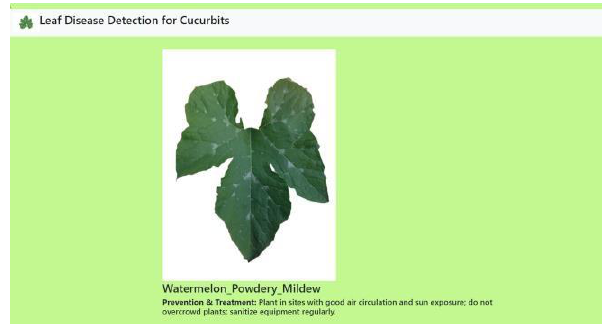
Fig 5. Image of leaf without background